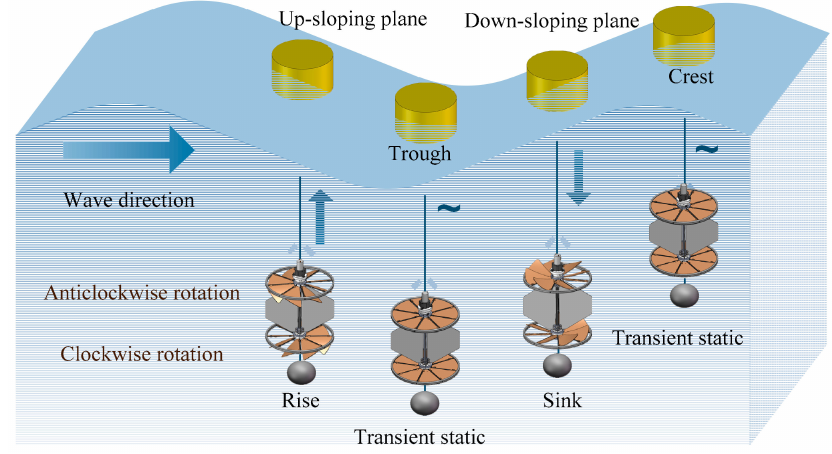
Figure 8. Working process of flexible blade WEC.